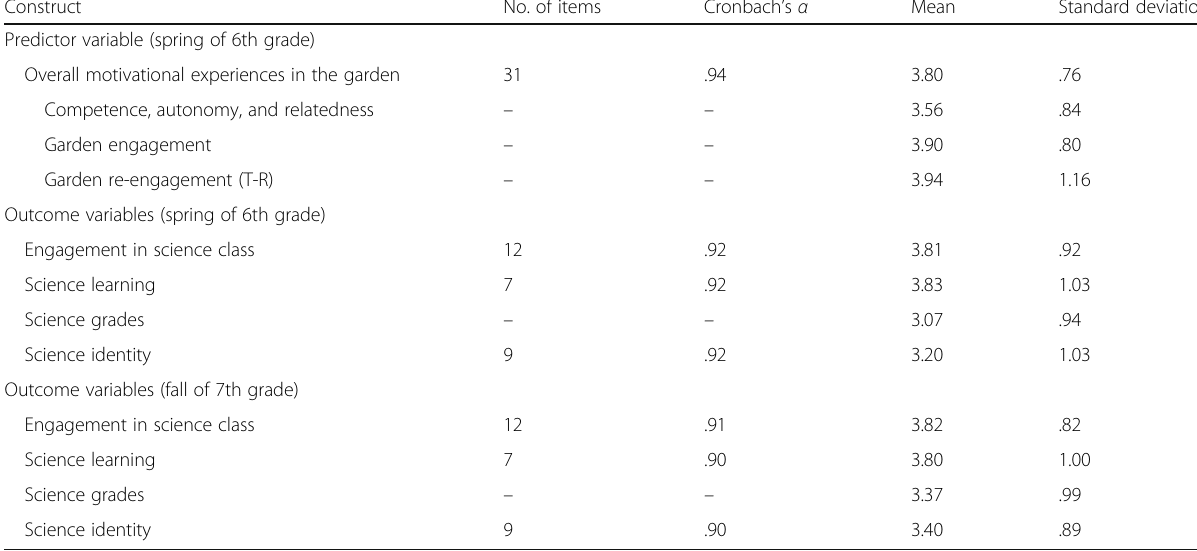
Table 1 Descriptive statistics and internal consistencies for spring of sixth grade and fall of seventh